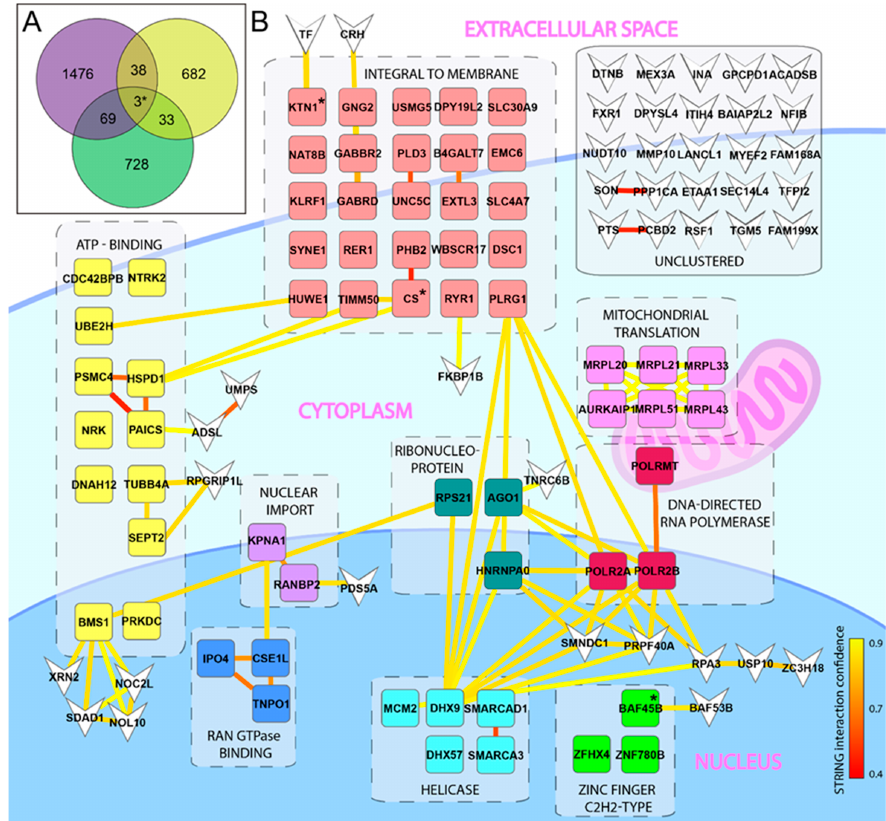
Figure 1. Identification of host factors important for ZIKV infection. ( A ) Venn diagram displaying overlapping genes of importance for ZIKV infection. A library of 60 cell lines (NCI-60) was infected with ZIKV and host factors of importance was identified using the COMPARE algorithm. Overlapping host factors from the NCI-60 (green), the Savidis et al. [28] screen (purple), and the Scaturro et al. [29] screen (yellow) are shown. The three genes identified in all three screens are marked with *. ( B ) Visualization of overlapping host factors that share functional annotations as identified by DAVID are clustered in boxes surrounded by dashed lines at their appropriated cellular localization with simplified annotations. Individual genes present in several functional clusters were allocated to the cluster with the highest enrichment. Yellow/red lines between genes indicate STRING interactions with confidence scoring as indicated by the lower right bar. Genes that were not allocated to a functional annotation cluster are displayed as inverted arrow heads. The three genes identified in all three screens are marked with “*”. Bioinformatic analysis of the three screens resulting in the Venn diagram was gener- ated using the on-line software Venny 2.0 (https://bioinfogp.cnb.csic.es/tools/venny/htm (accessed on 20 November 2020)) using only the genes showing a positive correlation with ZIKV infection in the NCI-60 screen. The Venn diagram was completed with all 756 guid- eRNA (gRNA)/genes identified in the CRISPR screen [28], and the 1586 targets identified